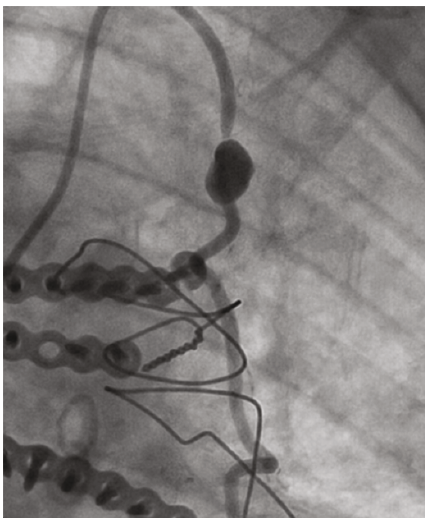
Figure 1: Large aneurysm in the left internal mammary artery to the left anterior descending artery bypass